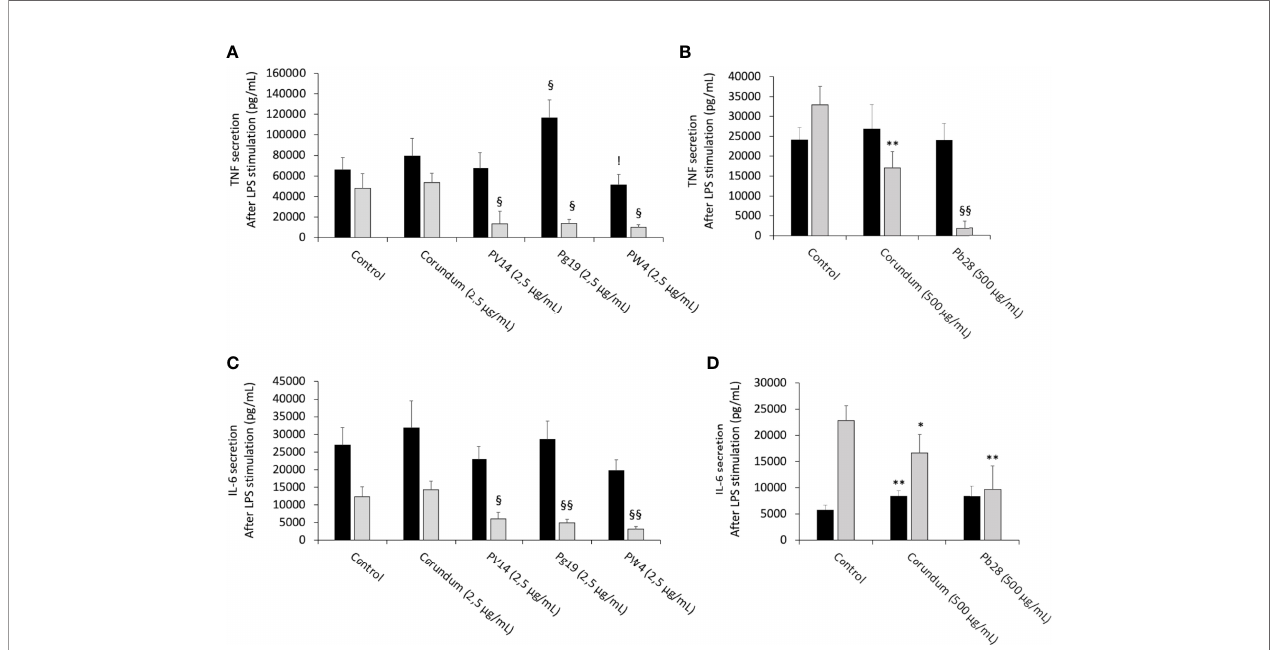
FIGURE 11 | Cytokine secretion after LPS stimulation. Black bars: acute exposure (24 hours). Grey bars: exposure for 24 hours followed by a 3-day post-exposure recovery period. Panel (A) TNF secretion. Conditions with 2.5 µg/ml of particle suspension. Panel (B) TNF secretion. Conditions with 500 µg/ml of particle suspension. Panel (C) IL-6 secretion. Conditions with 2.5 µg/ml of particle suspension. Panel (D) IL-6 secretion. Condition with 500 µg/ml of particle suspension. Signi fi cance of symbols: *: different from negative control only; §: different from both negative and corundum controls;!: different from corundum control only. Number of symbols: 1: p < 0.05; 2: p < 0.01.